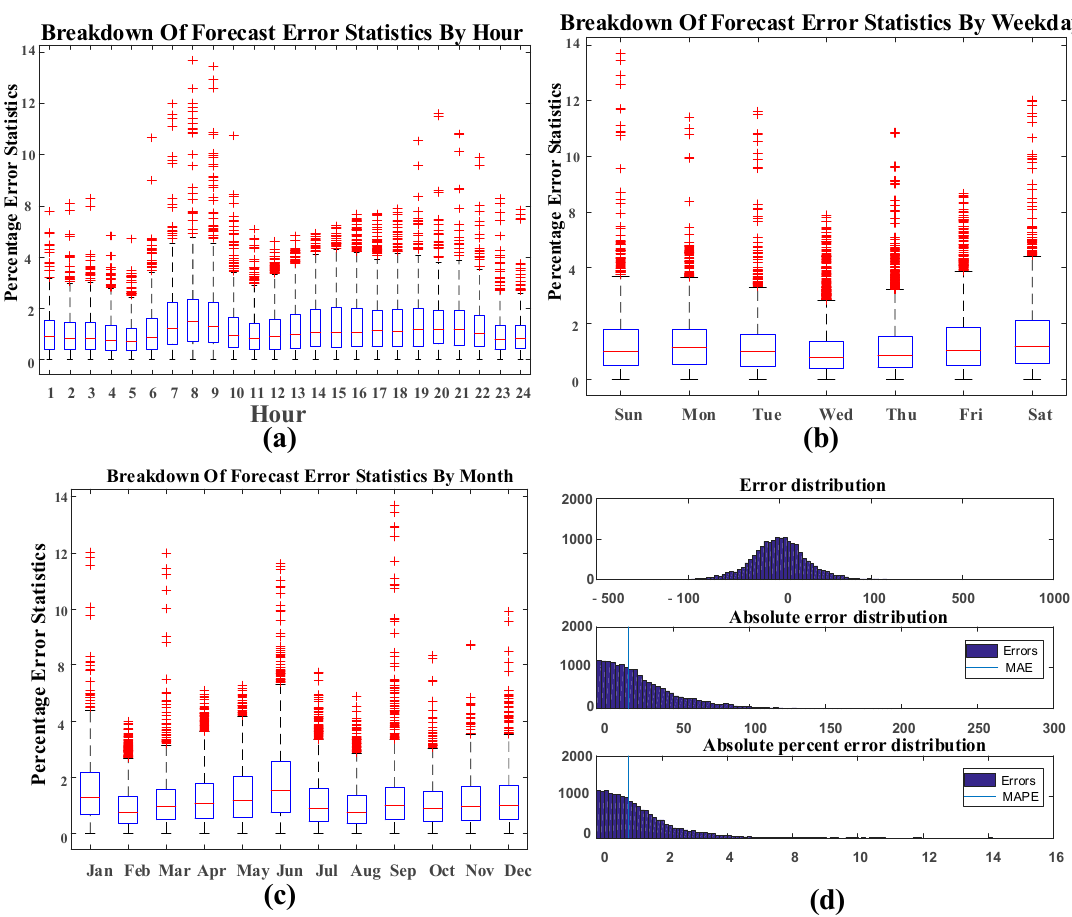
Figure 13. ( a ) Hourly error distribution, ( b ) weekly error distribution, ( c ) monthly error distribution, and ( d ) mean error distribution.